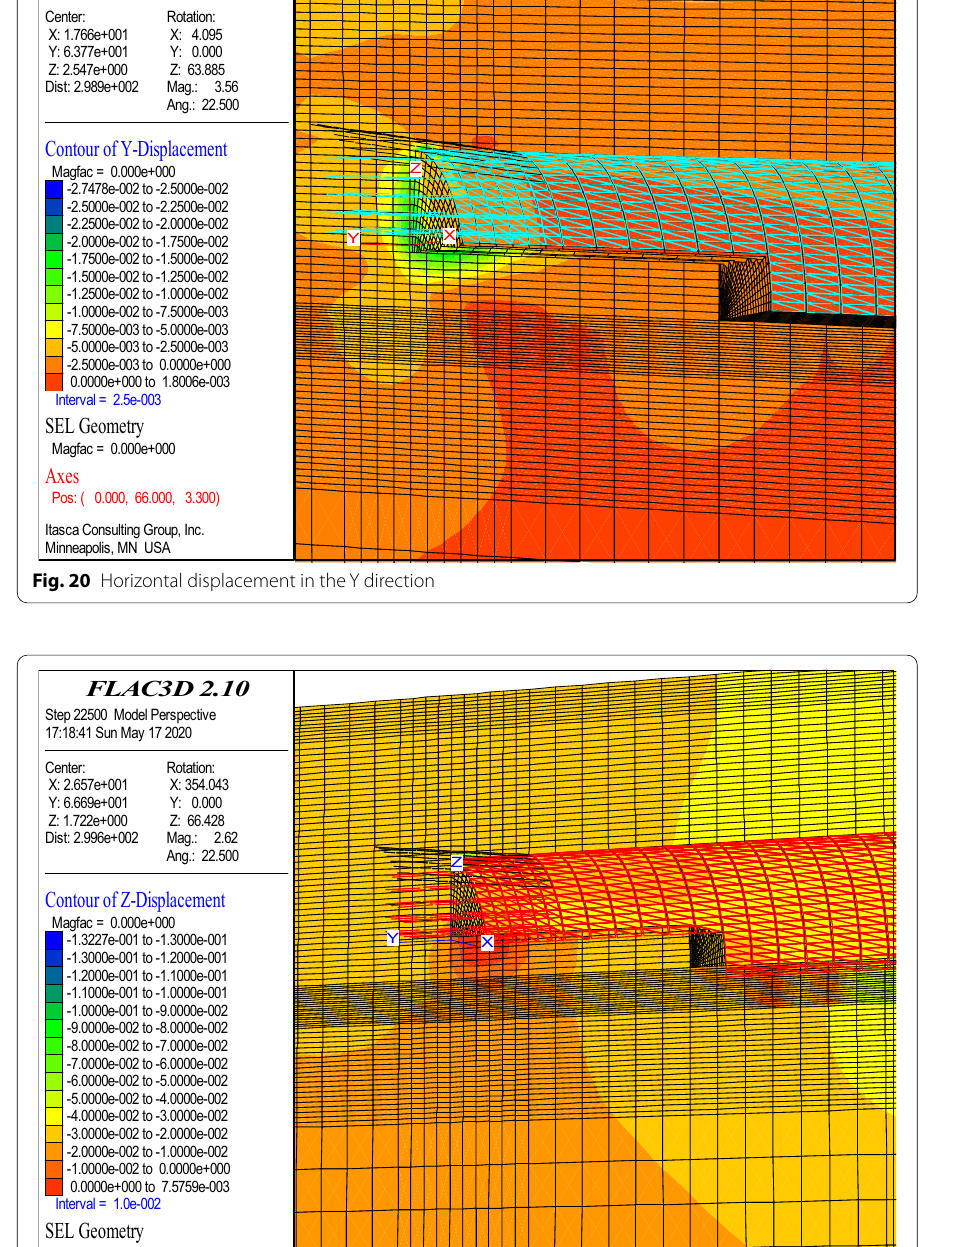
Fig. 21 Horizontal displacement in the Z